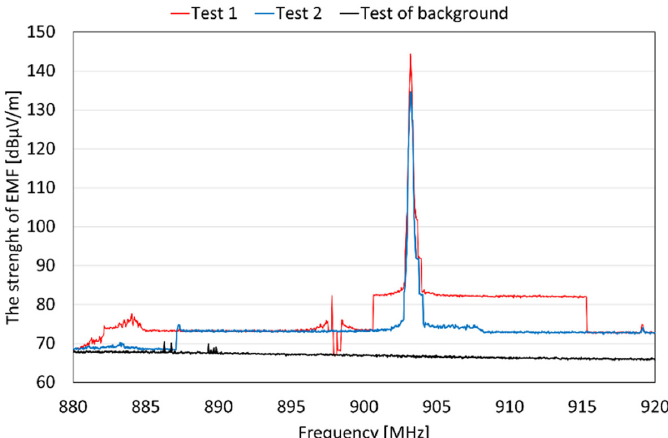
Figure 4. Measurement results of electromagnetic field strength generated from a device built on Arduino UNO at a distance of 5 cm.